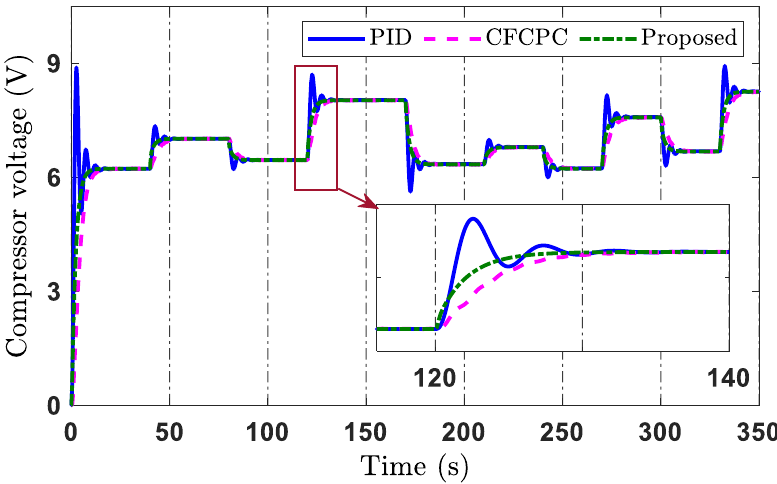
Figure 6. Voltage control input in the simulation.